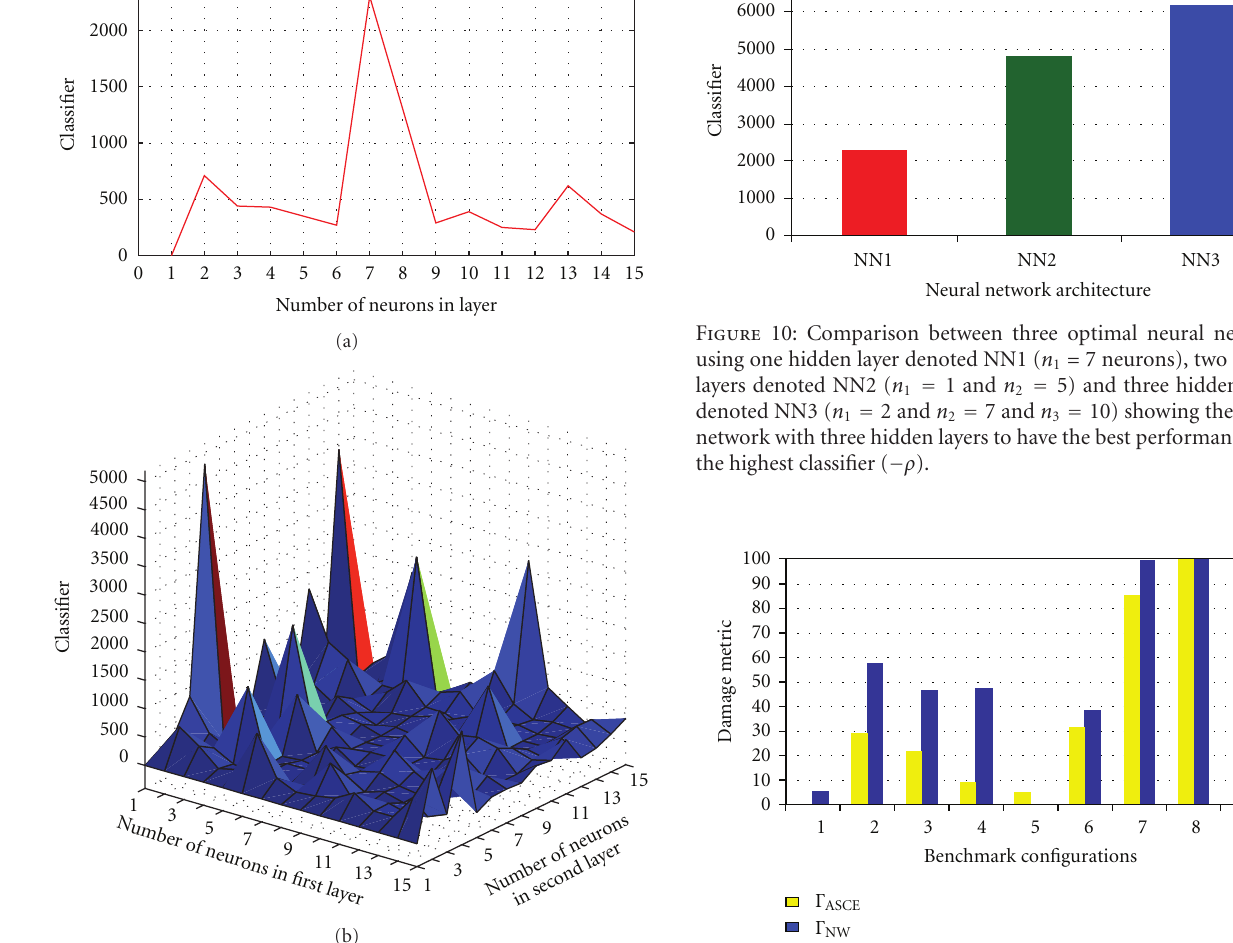
Figure 9: Number of neurons versus classifier objective function. (a) One hidden layer for classifier ( ρ ) showing the peak classifier to occur at n = 7 neurons. (b) Two hidden layers for classifier ( ρ ) showing the peak classifier to occur at n 1 = 1 and n 2 = 5.